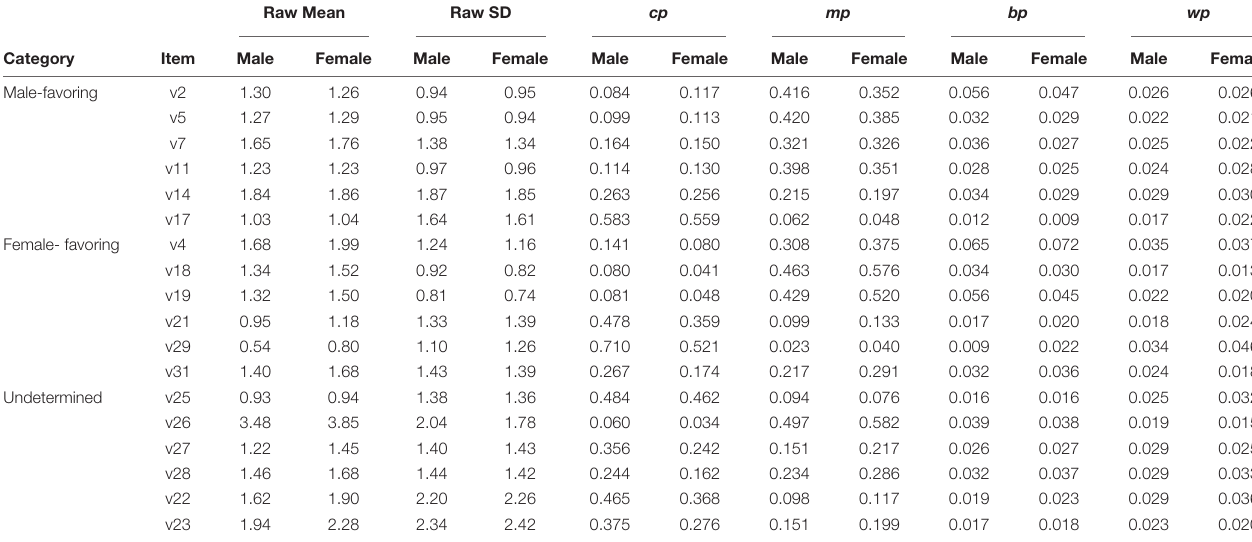
FIGURE 2 | Hit rates of differential item functioning (DIF)-flagged items according to multiple discriminant analysis. TABLE 2 | Values of Poly-BW indices for differential item functioning (DIF) items and undetermined items. Raw Mean Raw SD